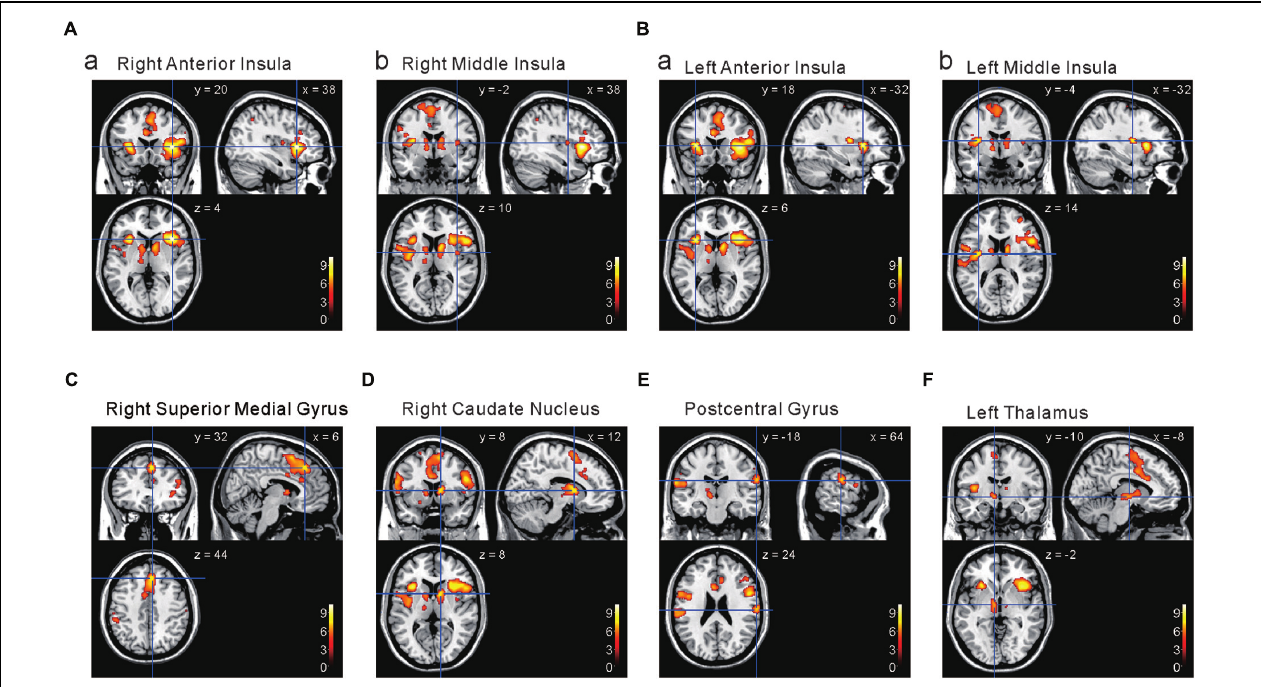
FIGURE 5 | Brain areas significantly activated by the comparison [2 × Capsaicin–NaCl–AS]. (A,B) The anterior and middle insula activated by capsaicin stimuli. (C–F) Brain areas particularly activated by capsaicin stimuli. ( x, y, z ) values represent Montreal Neurological Institute (MNI) coordinates (mm), and the color bar represents the T